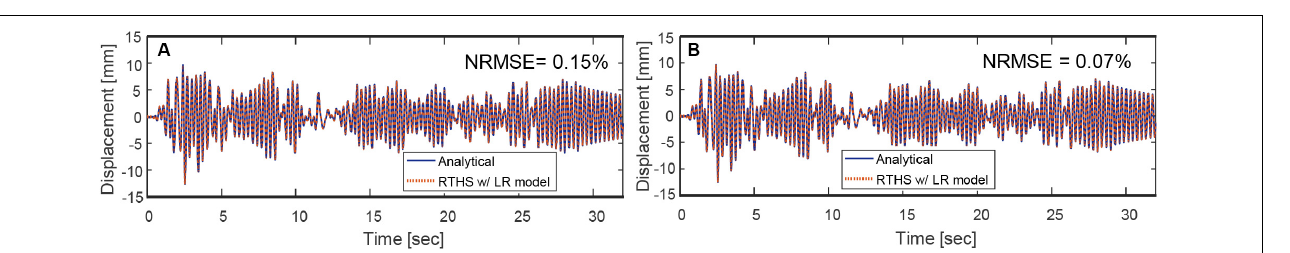
FIGURE 5 | Results from (A) offline and (B) online RTHS with the LR metamodel and validation against pure analytical